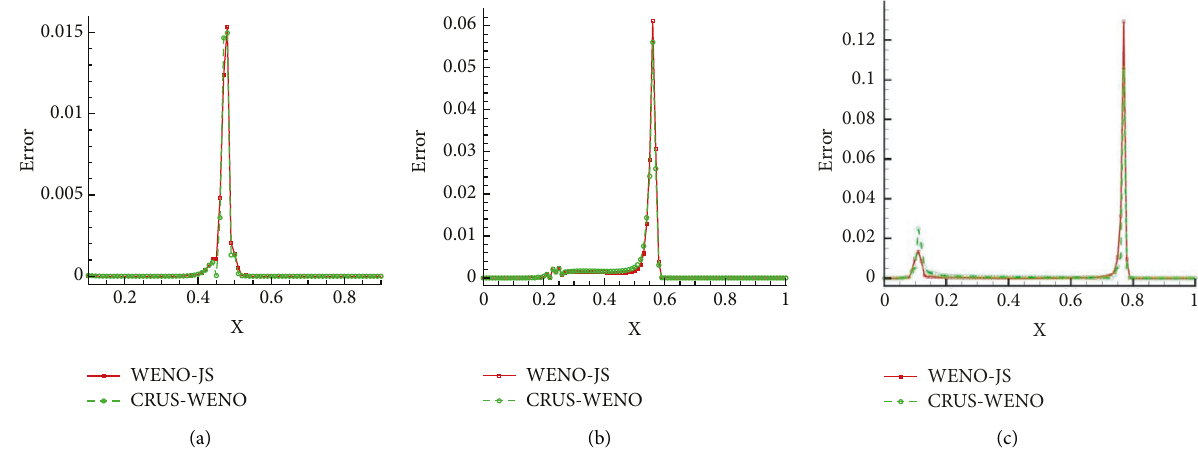
Figure 5: Example 5. Errors of WENO-JS scheme and CRUS-WENO scheme with 100 grid points. (a) shows the initial boundary value problem without gravity. (b) and (c) show the Riemann problem without gravity and with gravity, respectively. The reference solution is computed by WENO-JS scheme with 800 grid